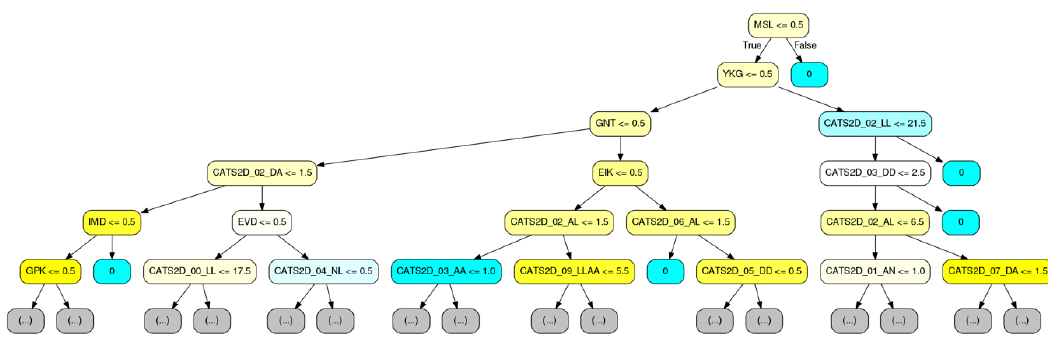
Figure 5. Deconvolution of ligand-target interaction prediction by custom visual rendering of decision trees (DTs) comprising random forests. The visualizations provide pinpoint description of the criteria identified in the samples and features presented to the DT-building algorithm (samples and features provided by random selection with replacement, known as bagging). Here, trees were constructed using CATS2D ligand descriptors with ( a ) dipeptide or ( b ) tripeptide descriptors. Node color intensity indicates the amount of purity obtained in for a decision based. Yellow coloring denotes inhibitory activity, and cyan color denotes non-inhibitory activity. Individual MCC/F1 performance on the external set is show below each tree.